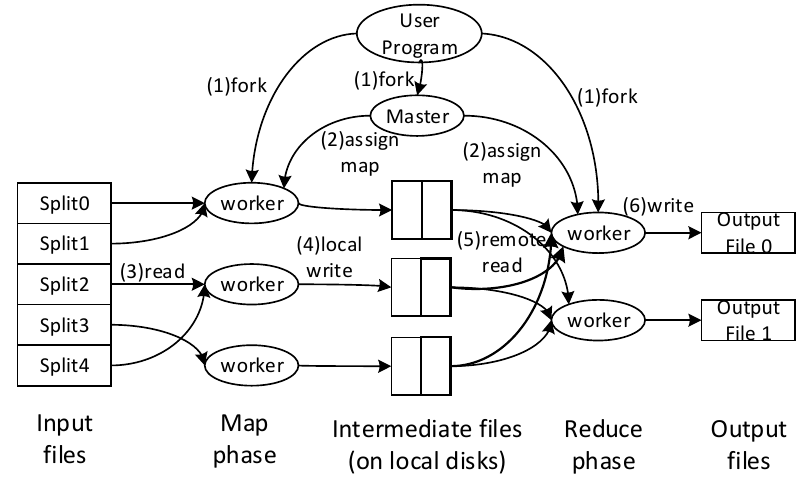
Figure 3. Main processes of MapReduce.